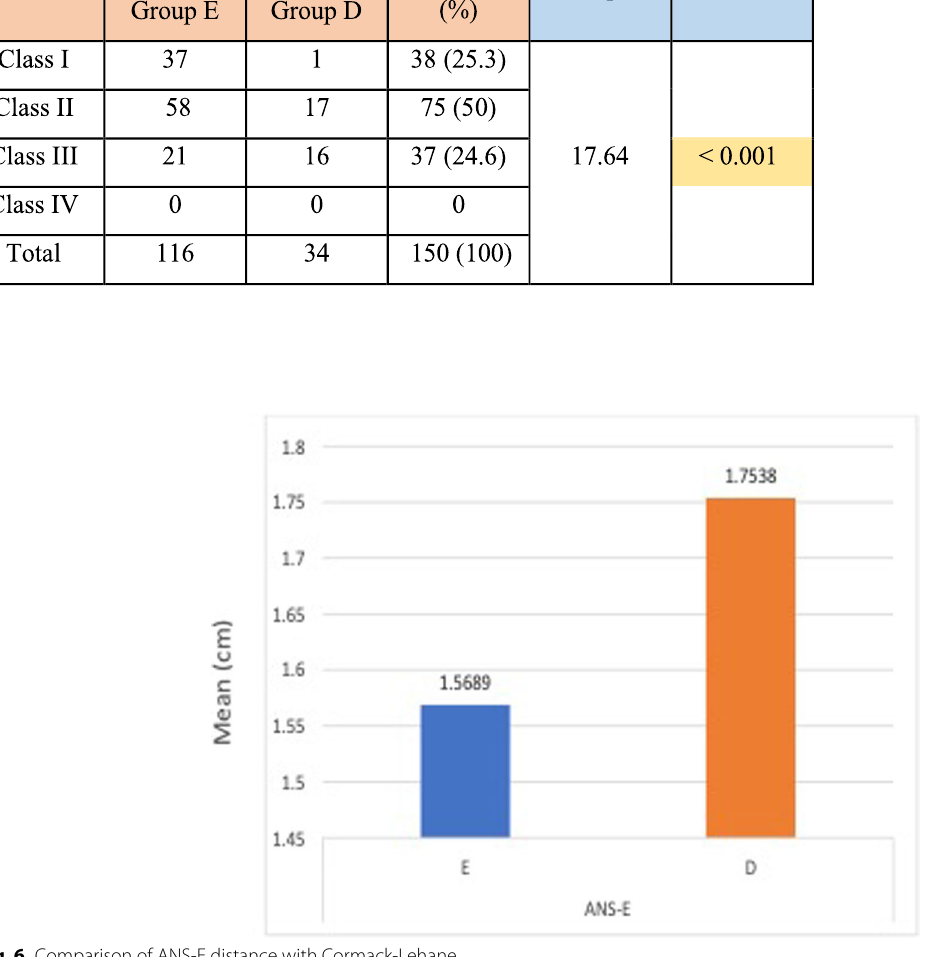
Fig. 6 Comparison of ANS-E distance with Cormack-Lehane